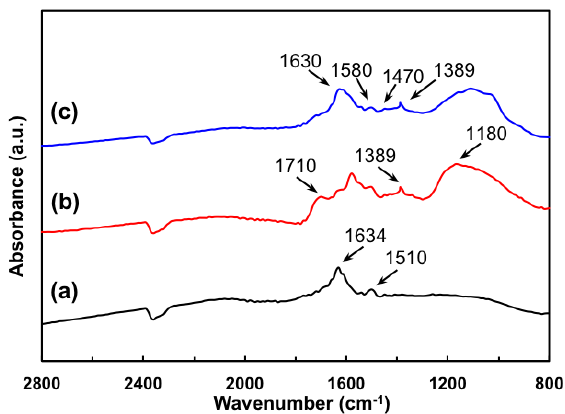
Figure 2. FTIR spectra of ( a ) pristine MWNTs, ( b ) acid-treated multi-walled carbon nanotubes (AT-MWNTs), and ( c ) amino-functionalized multi-walled carbon nanotubes (AF-MWNTs).